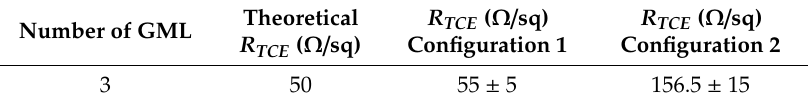
Table 2. Theoretical and measured sheet resistances of the TCEs that incorporated a stack of three GML and